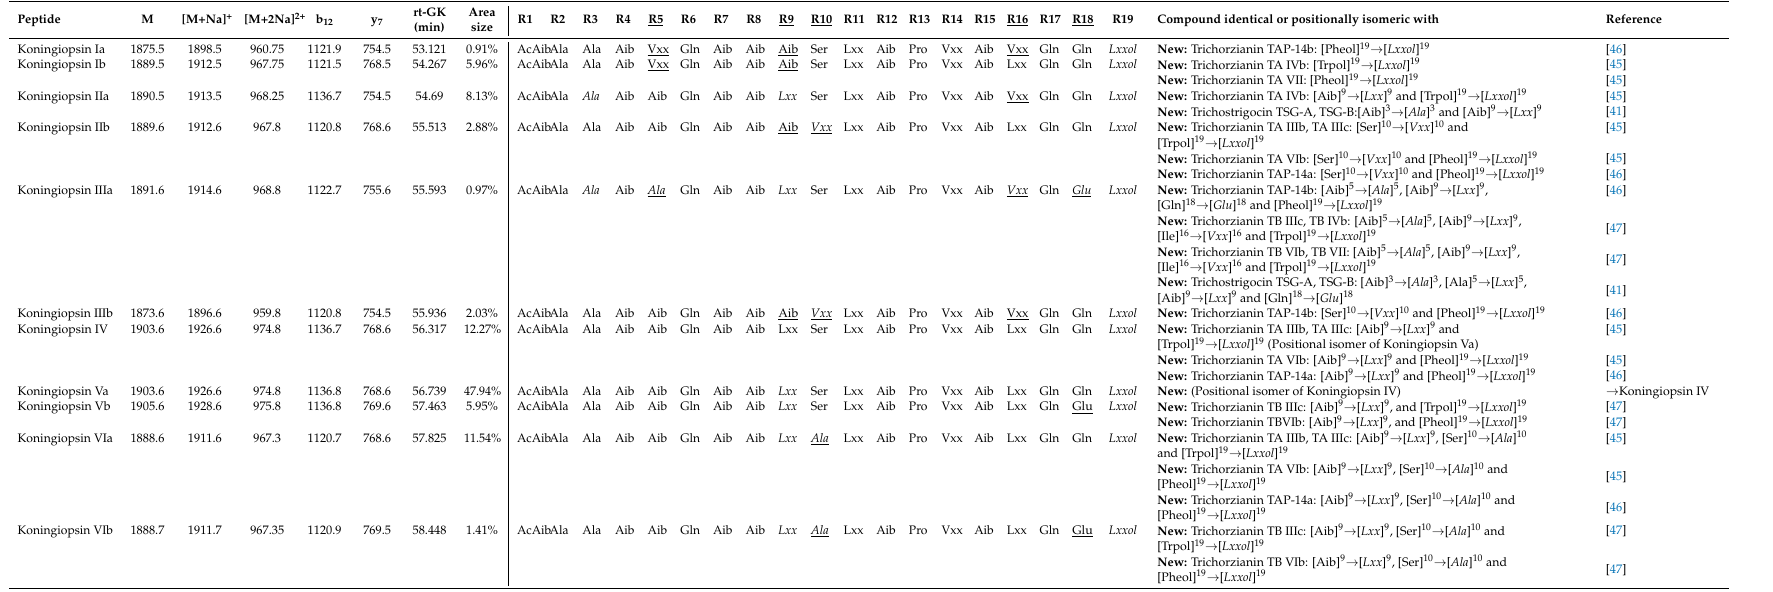
Table 2. Sequences of the newly identified peptaibol compounds produced by T. koningiopsis SZMC 12500 and their similarities to known peptaibols available in the “Peptaibiotics